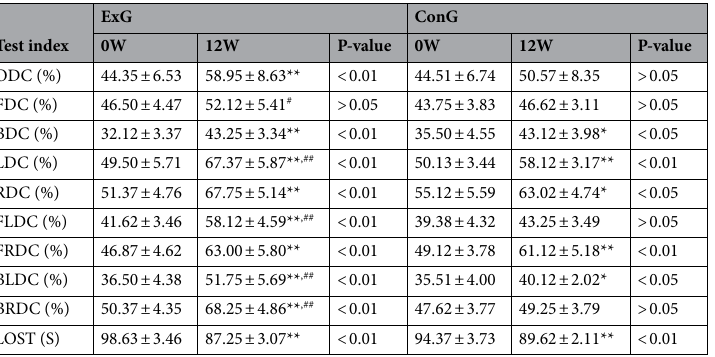
Table 3. Comparative analysis of subjects’ limits of stability (LOS) test results. Within-group differences *P < 0.05, **P < 0.01; Differences between groups # P < 0.05, ## P < 0.01.